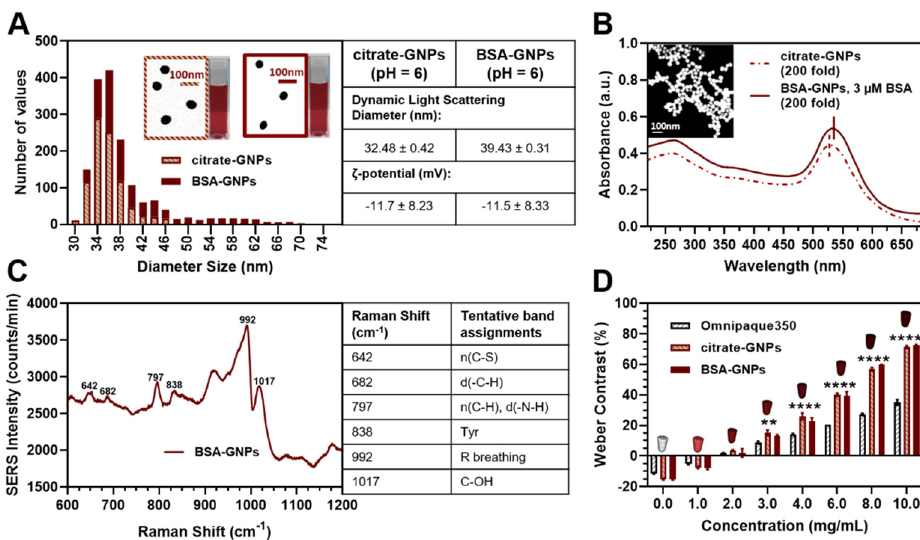
Figure 1. Gold nanoparticle (GNP) surface passivation and characterization. ( A ) Distribution analysis, size and charge: histograms ( n > 700) for citrate-GNPs and GNPs functionalized with bovine serum albumin (BSA-GNPs) calculated using a MATLAB algorithm based on scanning transmission electron microscopy (STEM) images. Insert table shows dynamic light scattering (DLS) diameter and ζ -potential. ( B ) Absorbance spectrum of citrate-GNPs (dashed line) and BSA-GNPs (solid line) as well as their size and shape captured by scanning electron microscopy (SEM) (inset represents citrate-GNPs). ( C ) Surface-enhanced Raman scattering (SERS) spectrum of BSA-GNPs and table of Raman shift values and tentative band assignments. ( D ) Weber contrast calculated based on computed tomography (CT) phantom and tumor background. Citrate-GNPs and BSA-GNPs present higher X-ray attenuation properties compared to a standard contrast agent (Omnipaque350). Significant differences between GNPs (citrate-GNPs and BSA-GNPs) and standard contrast agent for concentration above 3 mg/mL (** p < 0.005, **** p < 0.0001).